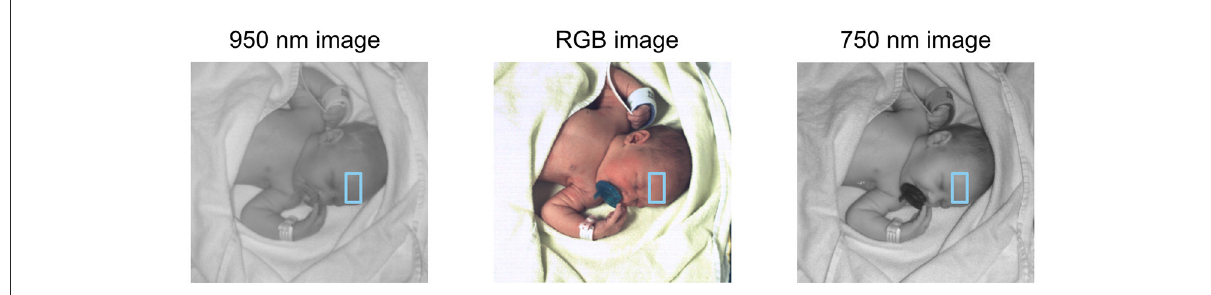
FIGURE2 Image of a newborn in different spectral ranges. From left to right: 950nm (NIR), RGB (visible light, true color), and 750nm (edge of visible light to NIR). The ROI is defined by keypoints in the RGB image and transferred unto the two others.